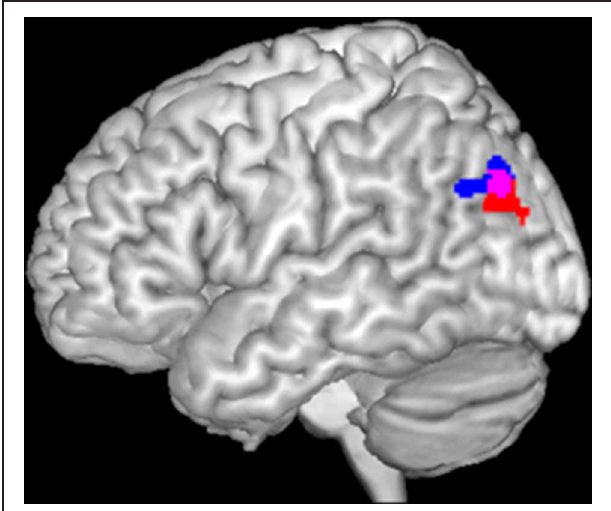
FIGURE 1 | Significant interaction between incongruence × group in left inferior parietal cortex in depression (blue) and schizophrenia (red). The overlap of both activations served as seed area (purple) for functional connectivity